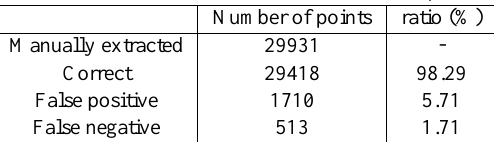
Table 1: The statistical evaluation of extracted points Number of points ratio (%) Manually